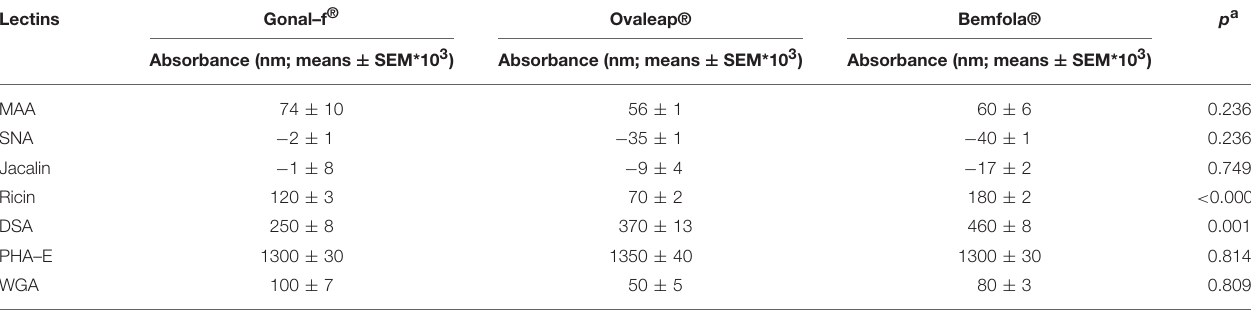
TABLE 1 | ELISA lectin analysis of reference and biosimilar follitropin alfa preparations. Lectins